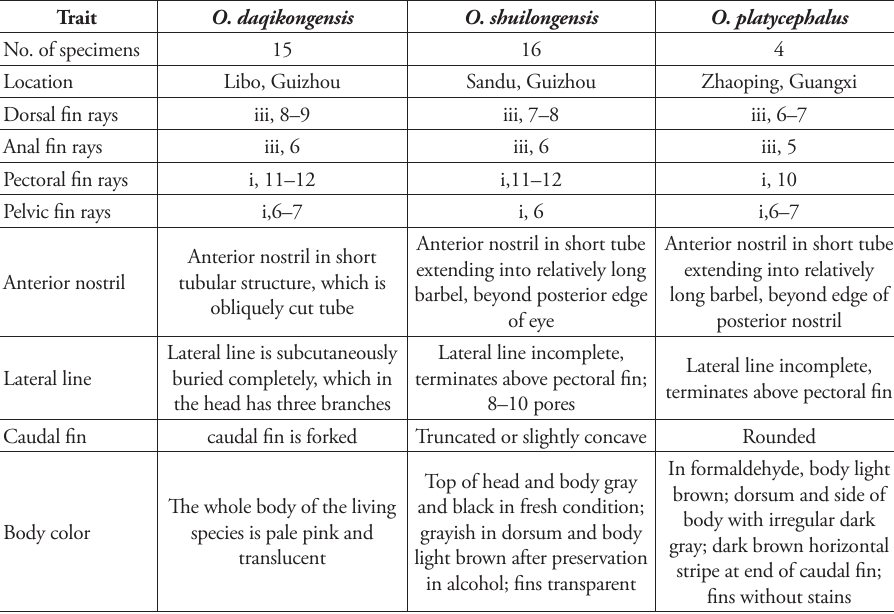
Table 4. Comparison of traits between O. daqikongensis sp. n. and similar species of Oreonectes . Trait Location Dorsal fin rays Anal fin rays Pectoral fin rays Pelvic fin rays Anterior nostril in short tube Anterior nostril in short extending into relatively long Anterior nostril tubular structure, which is obliquely cut tube Lateral line is subcutaneously Lateral line buried completely, which in Caudal fin caudal fin is forked Truncated or slightly concave Rounded The whole body of the living and black in fresh Body color species is pale pink and translucent